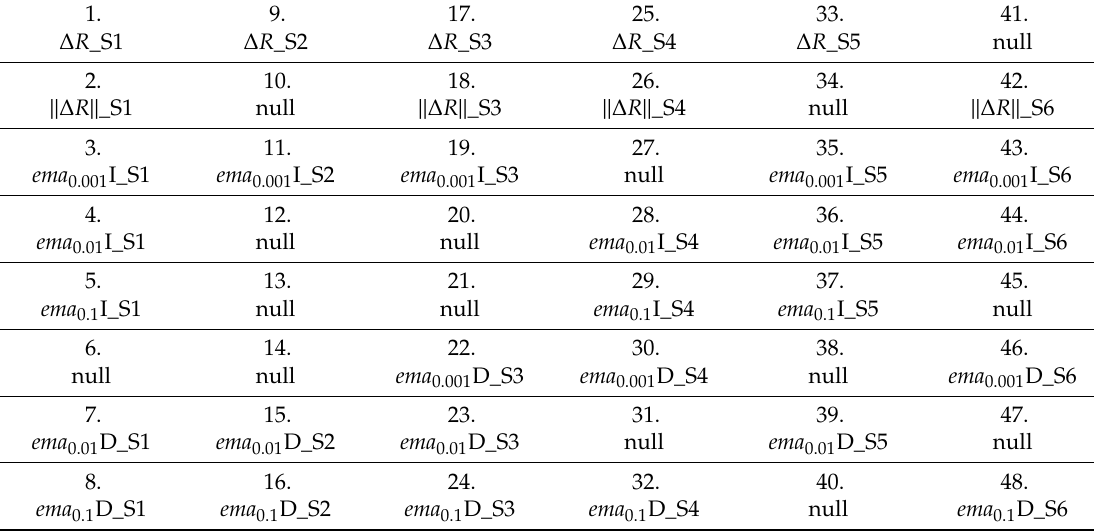
Table 3. Correlation analysis processing the partial